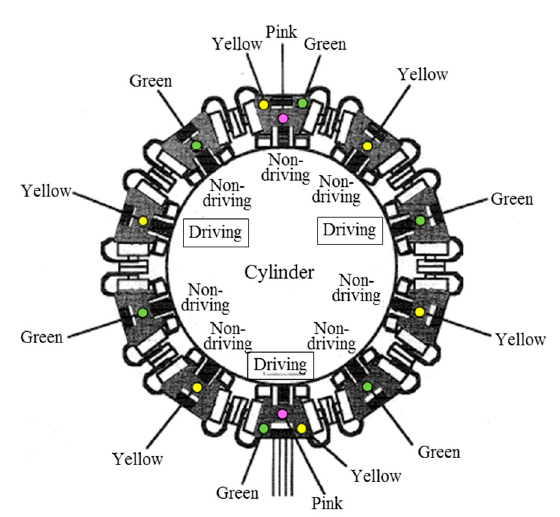
Figure 22. The layout of 10 connected microrobots and the arrangement of the marks for measurement. Among the 10 connected microrobots, the driving microrobot consisted of 3 microrobots: 1 main microrobot receiving the power supply by wire and 2 sub-microrobots receiving the power supply from the main microrobot through the connector; both are shown enclosed in a box. Three marks were illustrated in the main microrobot and the opposite microrobot. One mark each was illustrated for the other eight microrobots, and a different colored mark was used for the adjacent microrobot.